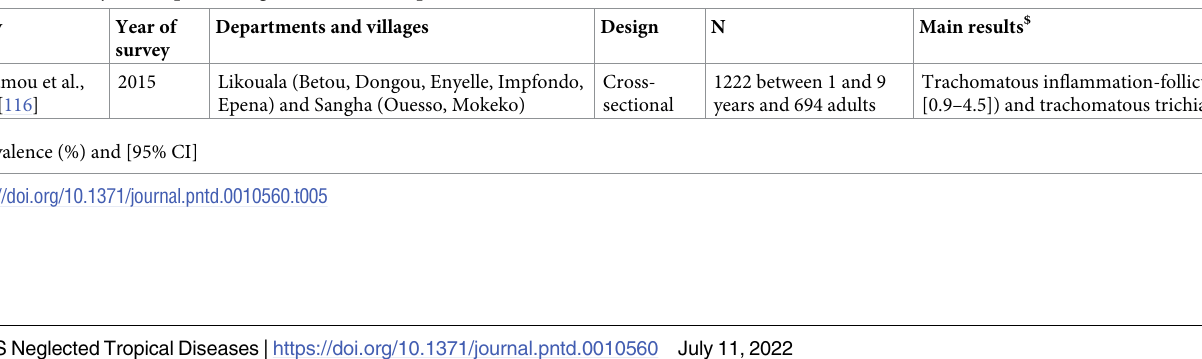
Table 5. Summary of the epidemiological studies and reports for